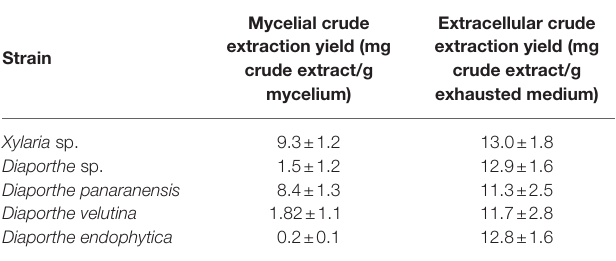
Mycelial crude Extracellular crude extraction yield (mg extraction yield (mg crude extract/g crude extract/g mycelium) exhausted medium)